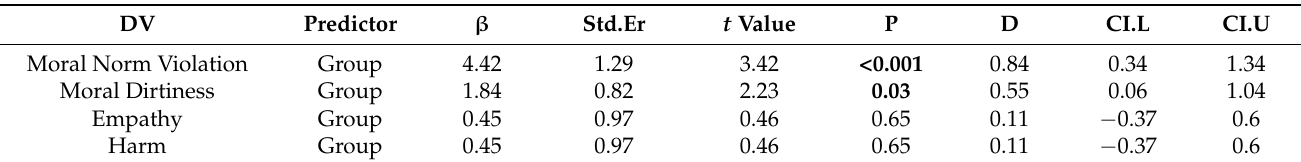
Table 2. Results of the regression models. Std d stands for standardized Cohen’s d. CI.L/CI.U: Lower and upper 95% confidence